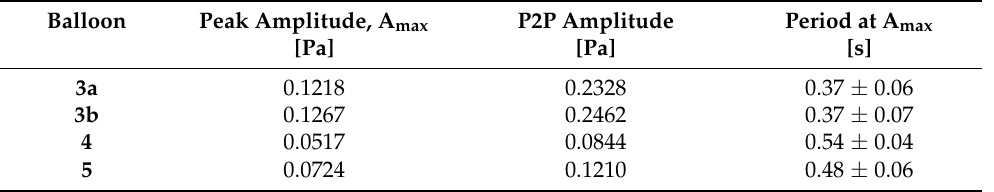
Table 2. Signal measurements associated with the dominant phase.